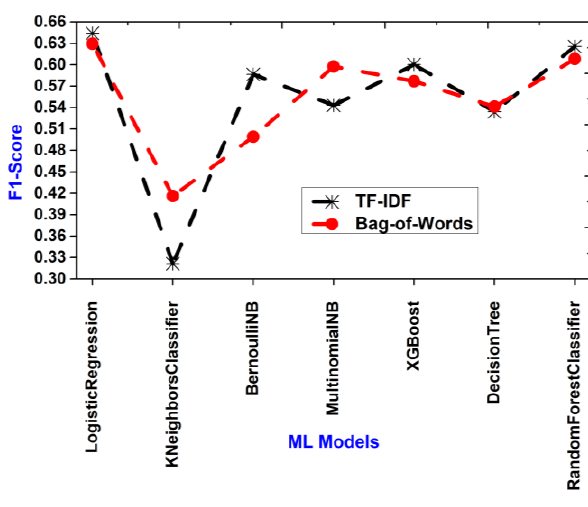
Fig. 1. F1-score for a dataset (movie reviews) using seven ML algorithms with TF-IDF and bag of words